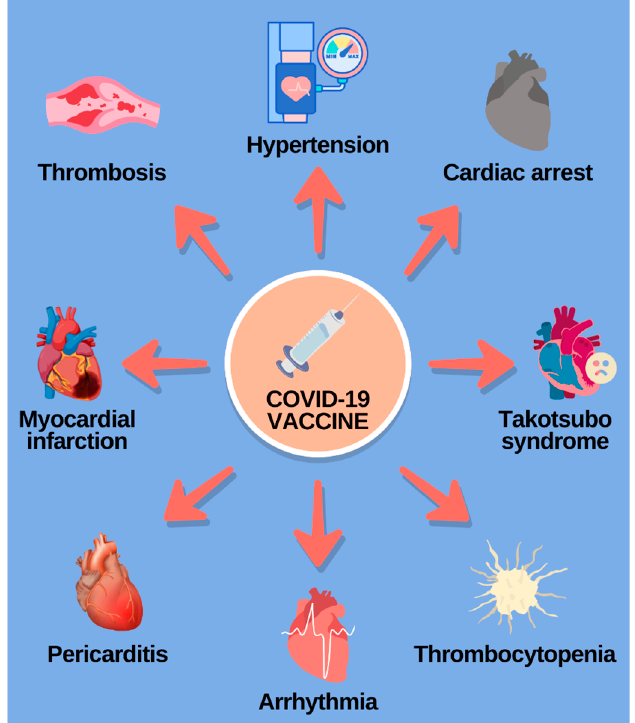
Figure 3. Diverse cardiovascular complications following the COVID-19 vaccination. (REFERENCE: elaborated by the authors, based on Liu, R.; Pan, J.; Zhang, C.; Sun, X. Cardiovascular Complications of COVID-19 Vaccines. Front Cardiovasc Med. 2022 , 9 , 1–7 [60]). From 29 December 2020 to 11 June 2021, there were 1226 noti fi cations of myocarditis